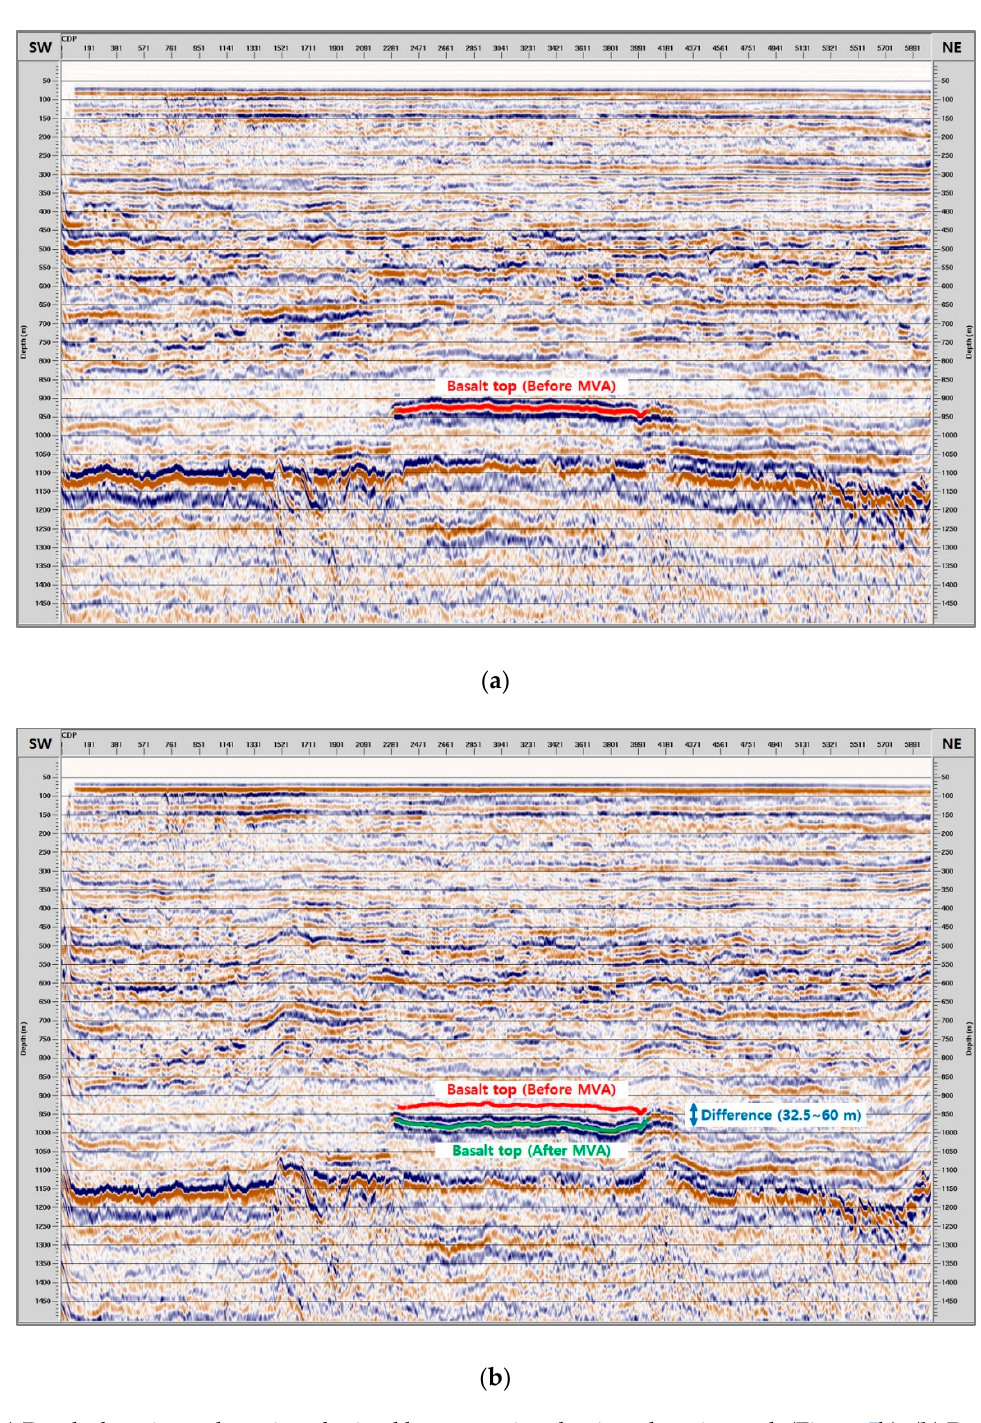
Figure 9. ( a ) Depth-domain stack section obtained by converting the time-domain result (Figure 5b). ( b ) Depth-domain stack section after applying MVA at the 3rd iteration. The red and green lines represent the top of the basalt before and after applying MVA, respectively. The difference in depth between the two basalt tops ranges from 32.5 to 60 m.